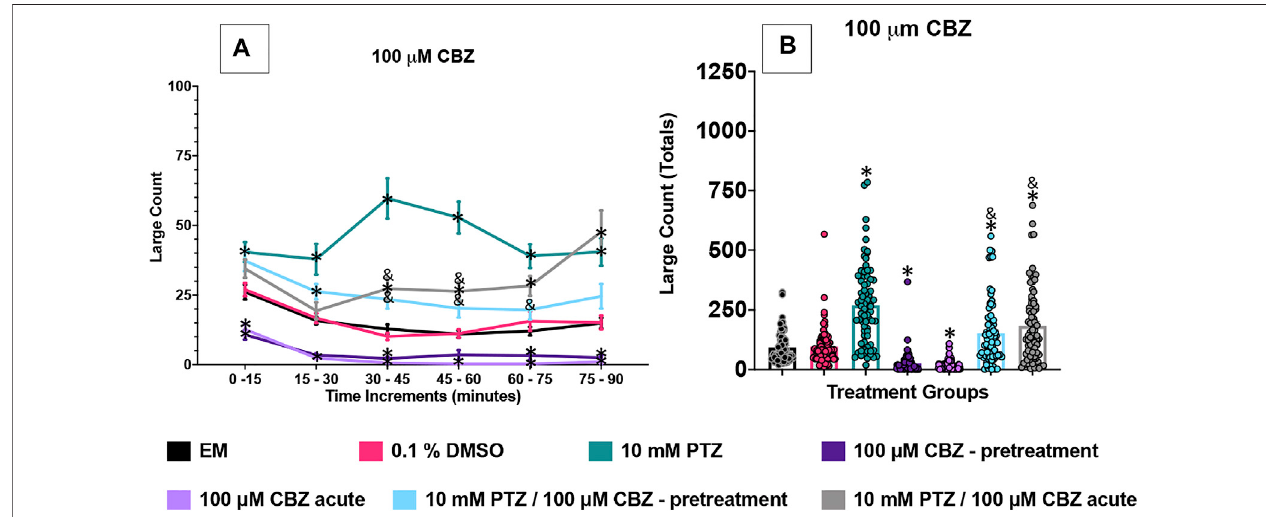
FIGURE2| Behavioralpro fi leofzebra fi shlarvaeexposedtocarbamazepine (A) displays theaveragelargecount ( y -axis)oflarvae.Theaveragelarvallarge countis depicted per 15 min interval ( x -axis) of the tracking session. The respective treatment groups are listed on the x -axis. Analyses (two-way ANOVA, Tukey ’ s post-hoc) are marked* ( p < 0.05) toindicate signi fi cant differences toembryo medium (EM).Standard error ofthemeans isshown. Analyses (two-way ANOVA, Tukey ’ spost-hoc) are markedand ( p < 0.05) toindicate signi fi cantdifferences to 10 mM PTZ. (B) Thetotal large count ( y -axis) over 90 min isdisplayed. Therespectivetreatmentgroups ( x -axis).Analyses(one-way ANOVA, Tukey ’ spost-hoc) aremarked*( p < 0.05) toindicatesigni fi cantdifferencestoembryomedium (EM).Standarderrorofthemeansis shown. Analyses (one-way ANOVA, Tukey ’ s post-hoc) are marked & ( p < 0.05) to indicate signi fi cant differences to 10 mM PTZ. ( n = 76 fi sh/treatment group).